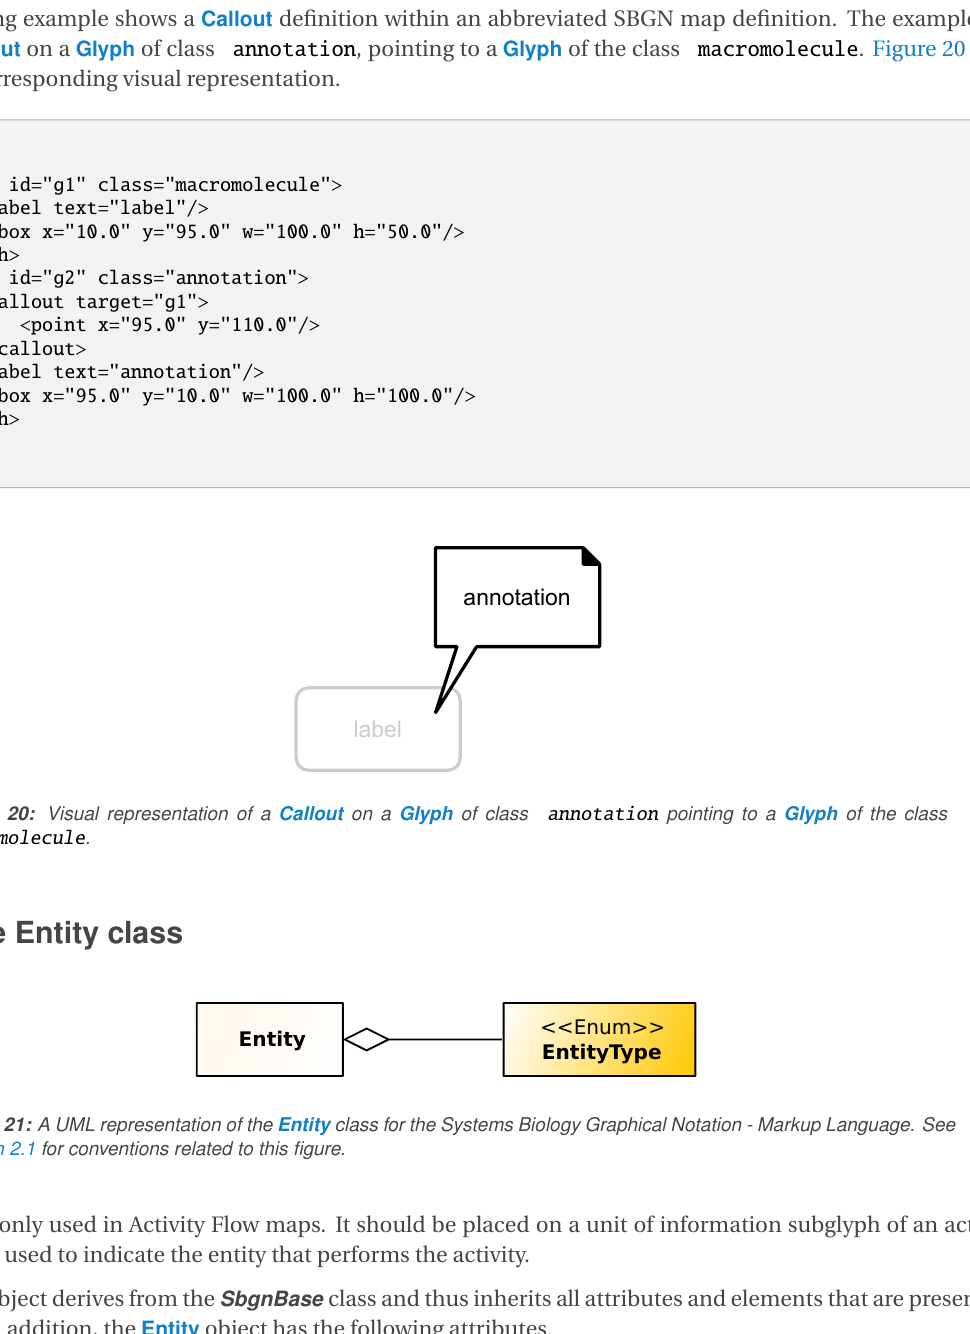
An entity is only used in Activity Flow maps. It should be placed on a unit of information subglyph of an activity 26 glyph and is used to indicate the entity that performs the